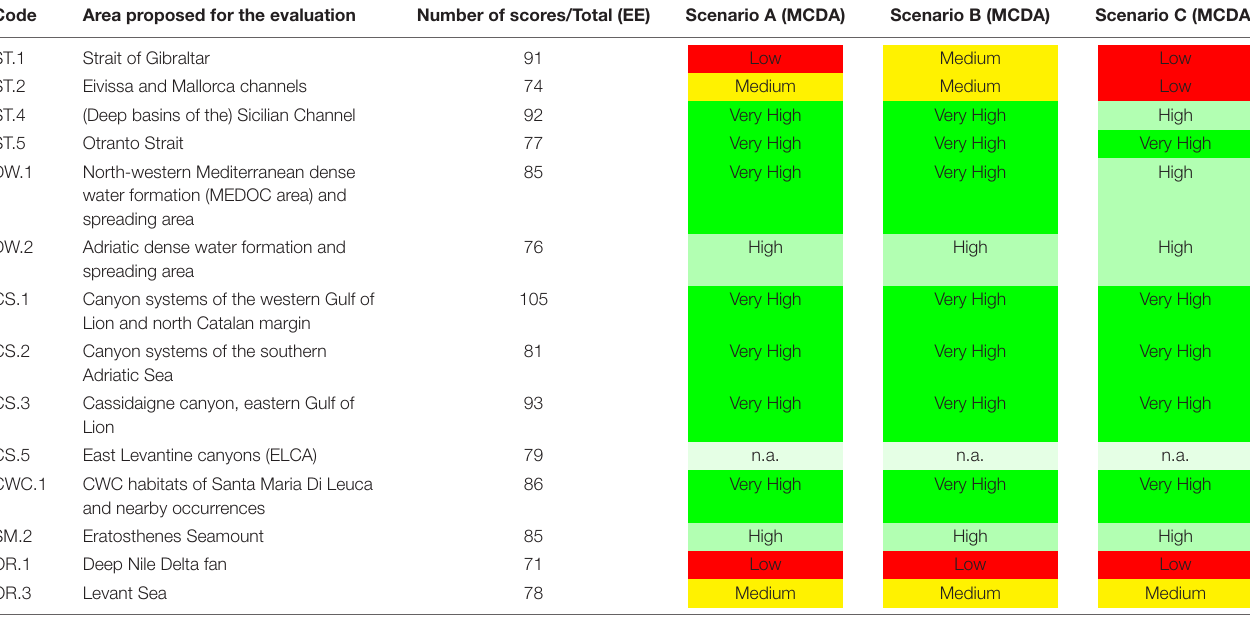
TABLE 4 | List of Type 1 areas according to expert evaluation (EE), with the number of scores obtained by each of them, and suitability scores according to the three scenarios of the multi-criteria decision analysis (MCDA), also for each of them. Colors for the different scenarios of the MCDA represent the score obtained by the analysis: red = low score; yellow = medium score; light green = high score and green = very-high